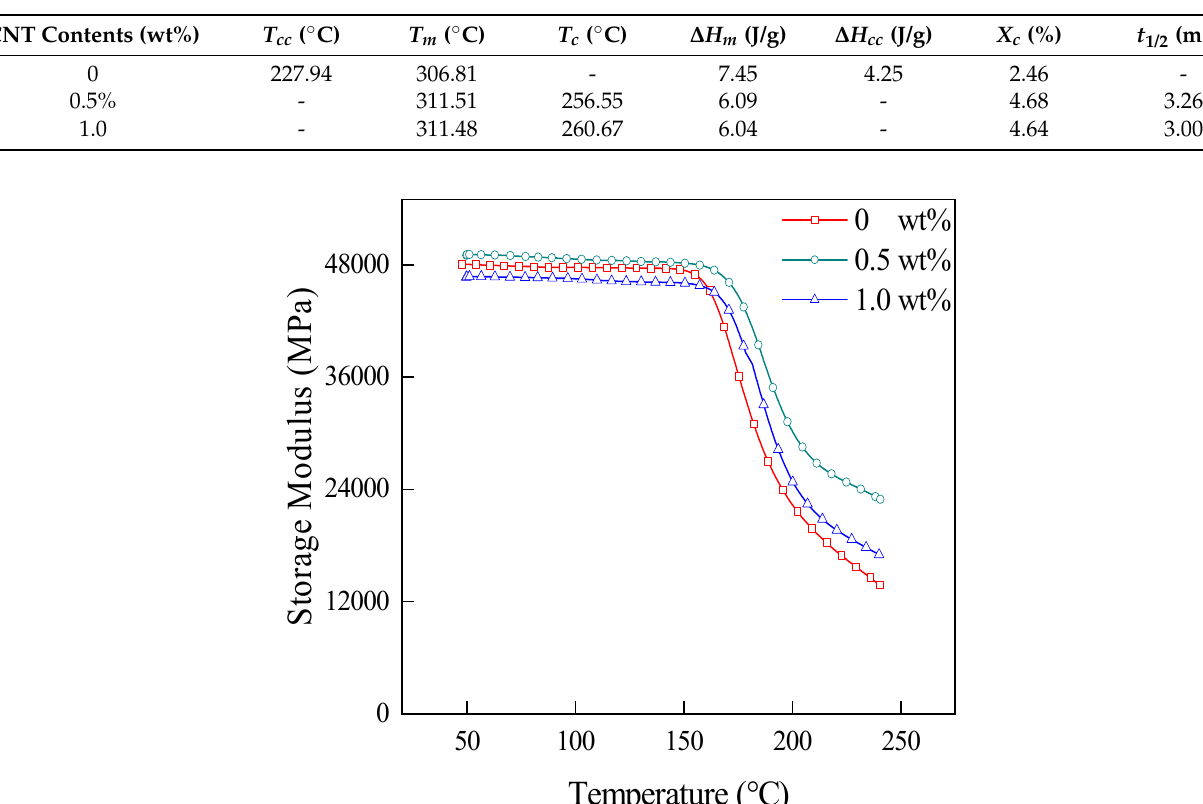
The loss factor (tan δ ) is the ratio of loss modulus ( E ″ ) to E ′ . Figure 12 shows the tan δ -temperature curves of the three laminates. In this figure, the tan δ peak temperature is lower for the laminate without CNT compared to the laminates with CNT, which indicates that the addition of CNT increases the resistance of the laminate to high temperature de-